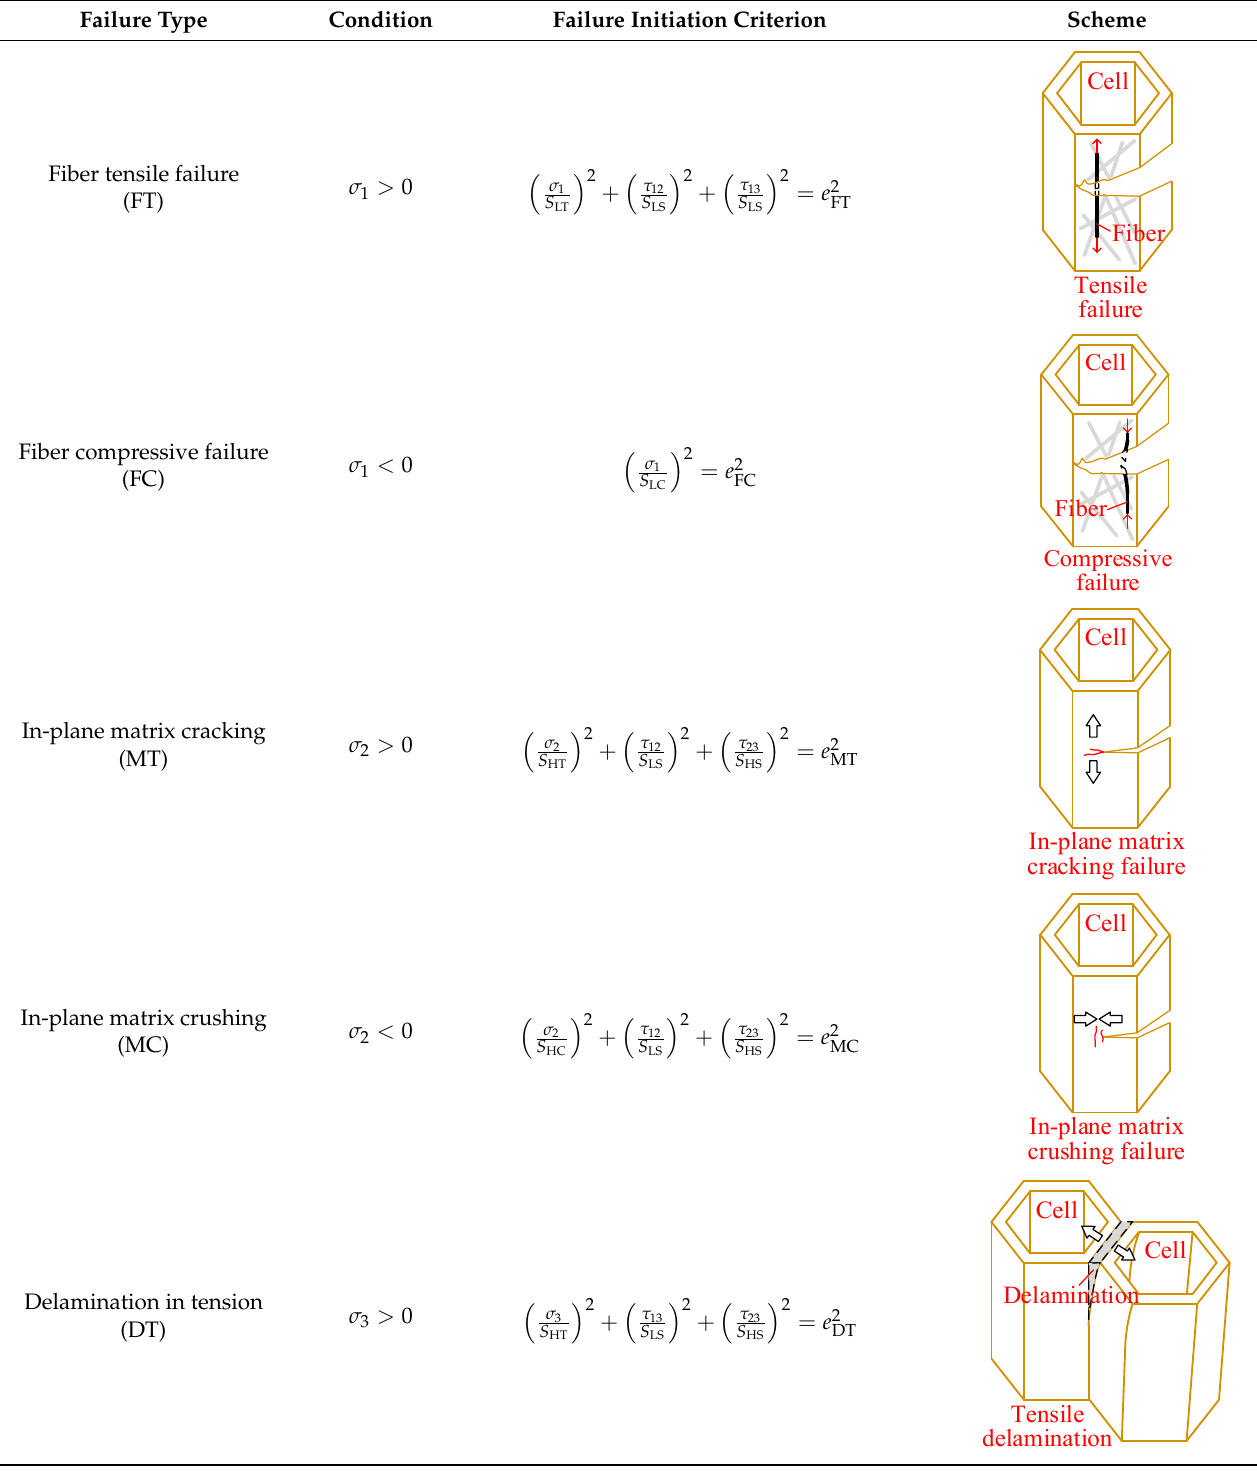
Table 2. Initiation criteria and schemes for seven failure types.